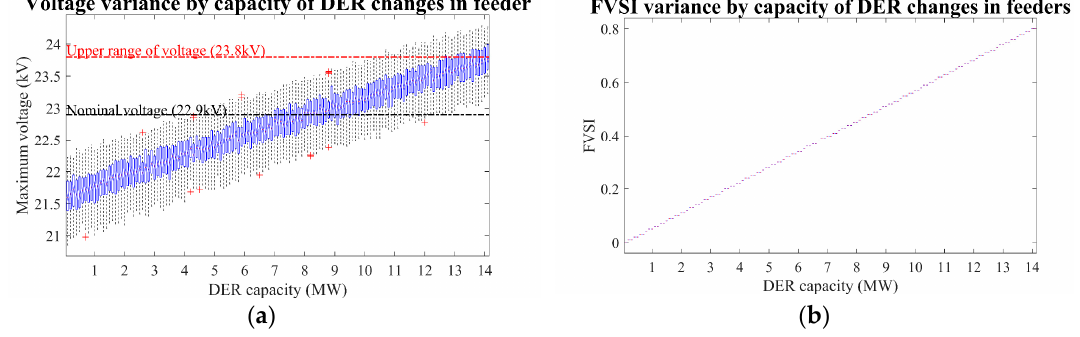
Figure 7. The result for the feeder ( a ) voltage variance, ( b ) FVSI